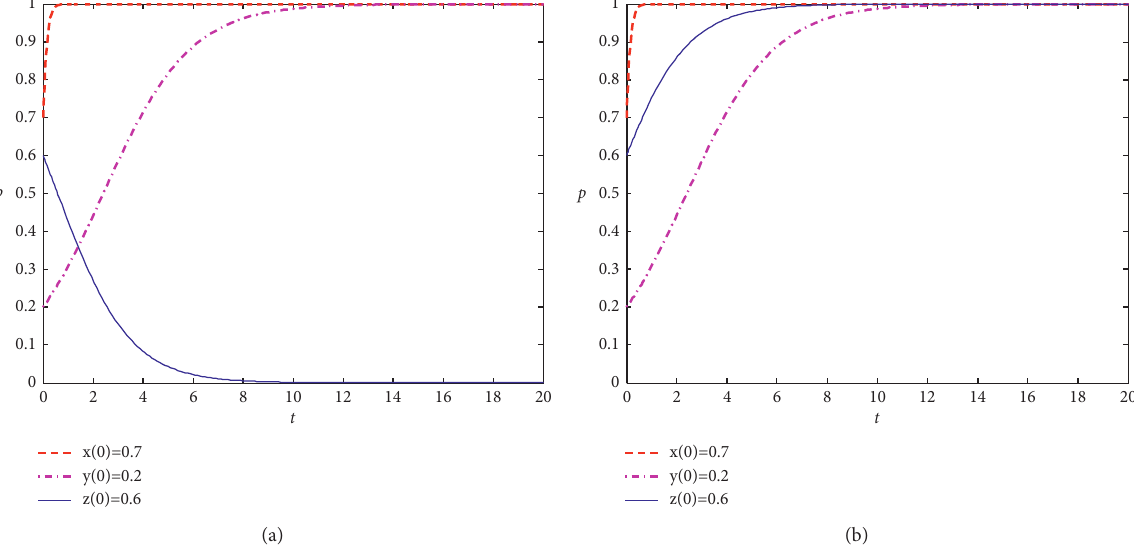
Figure 10: The impact of repayment incentives and defaulting opportunity costs on evolutionary results. (a) V � 1, and D � 0.8. (b) V � 4, and D �